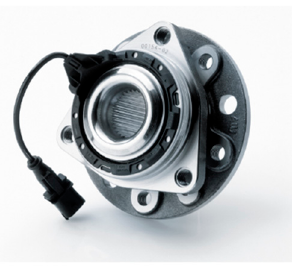
Figure 2. Wheel bearing with integrated ABS sensor (picture: Schaeffler AG) [13].